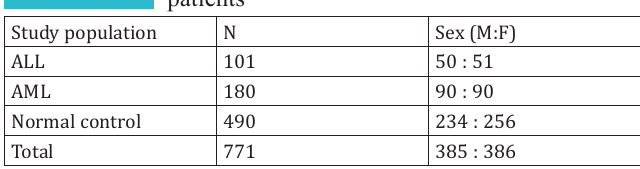
Socio-economic factors of the 388 cataract patients